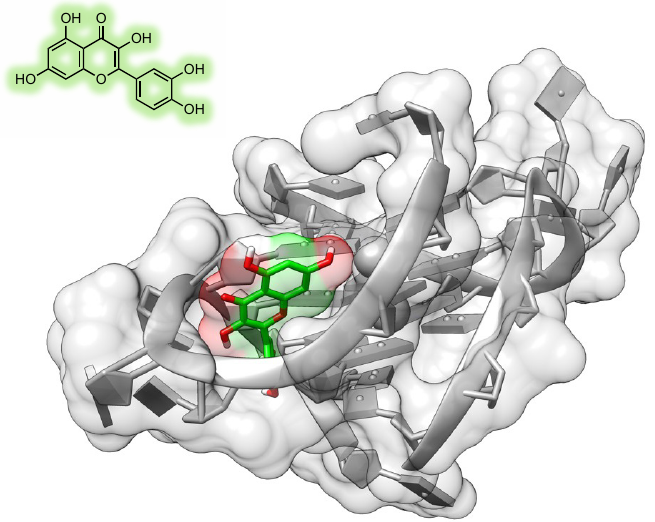
Figure 5. Quercetin structure and predicted binging mode to a G-quadruplex DNA sequence (Protein Data Bank ID: 3CE5; adapted from [190]). The artwork was produced using UCSF Chimera [191].